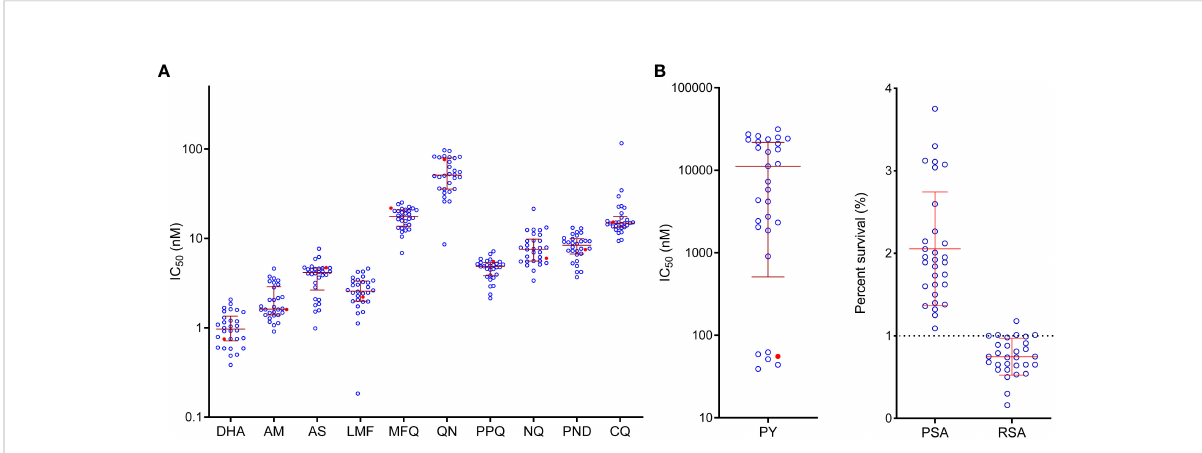
FIGURE 1 In vitro susceptibility of P. falciparum isolates to antimalarial drugs. (A) IC 50 values. Each point represents the results for a single isolate. Mean IC 50 values and SD are shown by the red horizontal bars. The red symbol represents the value of the laboratory strain 3D7. DHA, dihydroartemisinin; AM, artemether; AS, artesunate; LMF, lumefantrine; MFQ, me fl oquine; QN, quinine; PPQ, piperaquine; NQ,